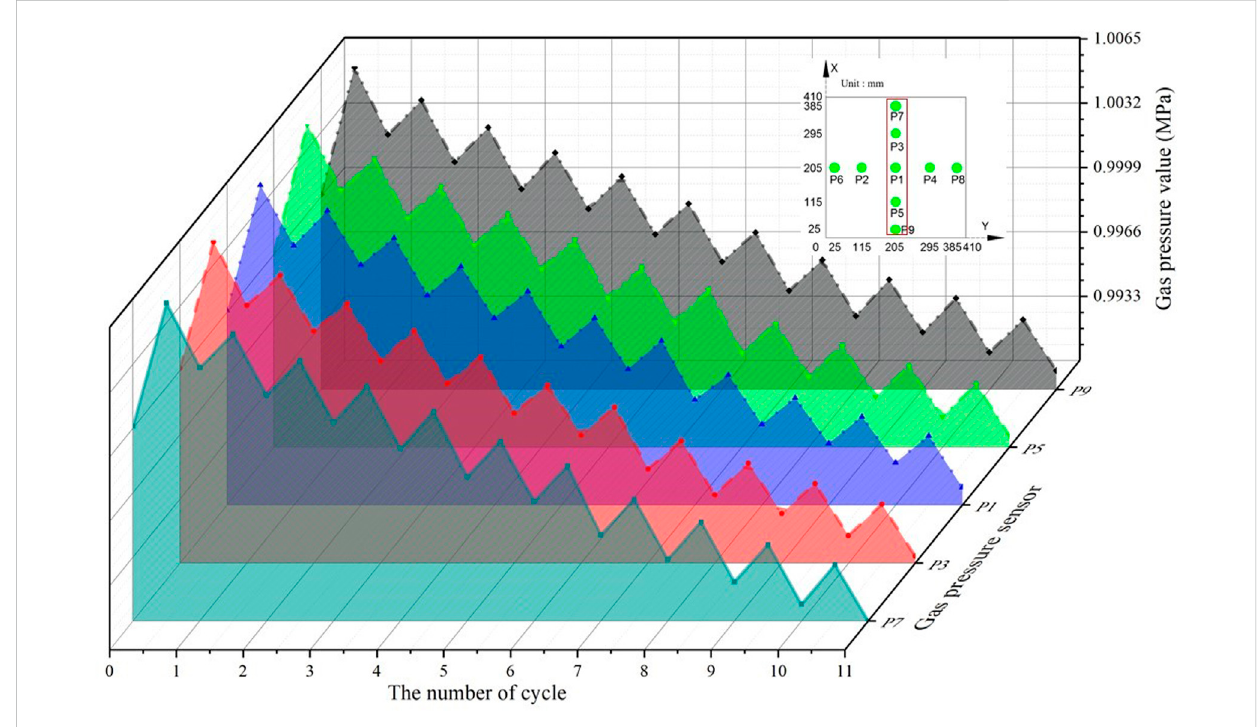
FIGURE 7 Relationship between gas pressure change and cycle